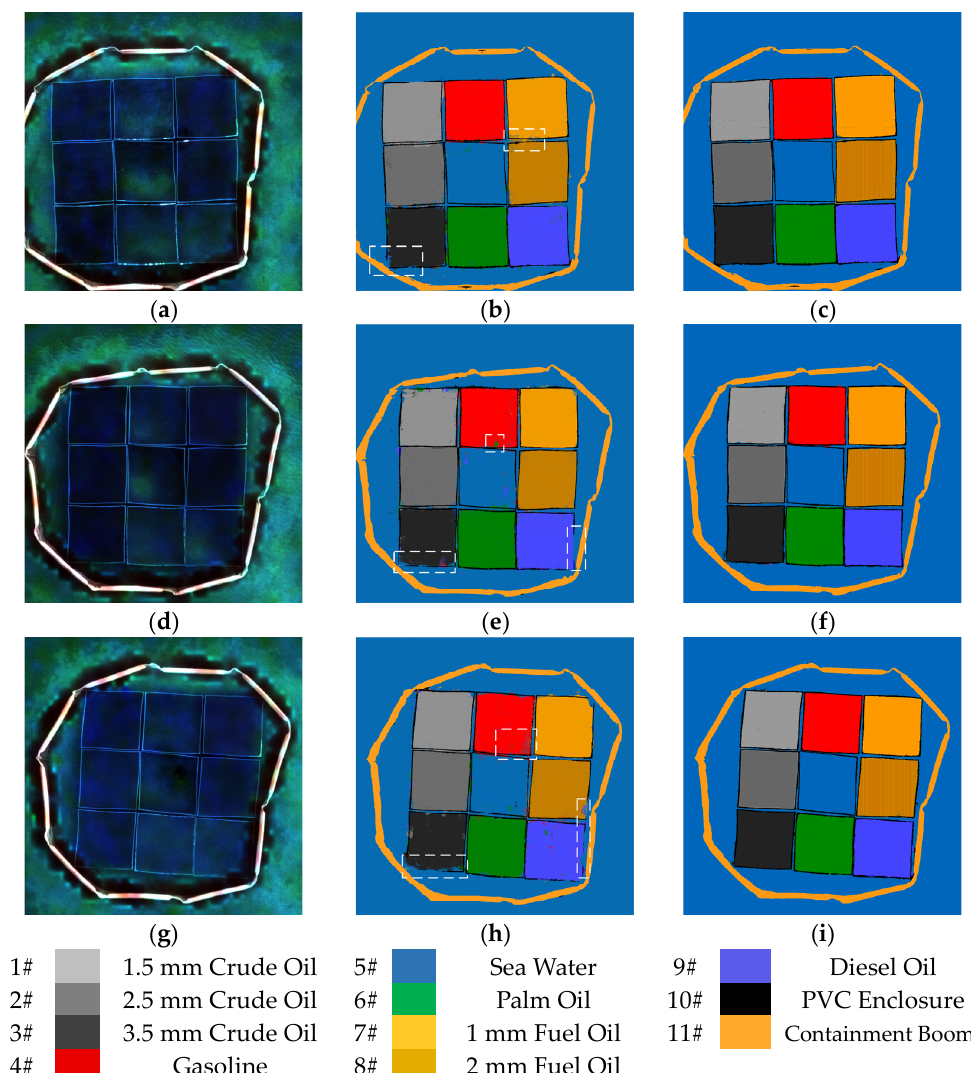
Figure 15. Detection results of the oil spill detection model with the ALTME optimizer. ( a , d , g ) represent the true color images at T1–T3, respectively (red: 482 nm, green: 550 nm, blue: 662 nm). ( b , e , h ) are detection results of the basic 1D-CNN model at T1–T3, respectively. ( c , f , i ) are detection results of the 1D-CNN model with ALTME optimizer at T1–T3, respectively. The white boxes indicate incorrect recognitions obtained by the basic 1D-CNN